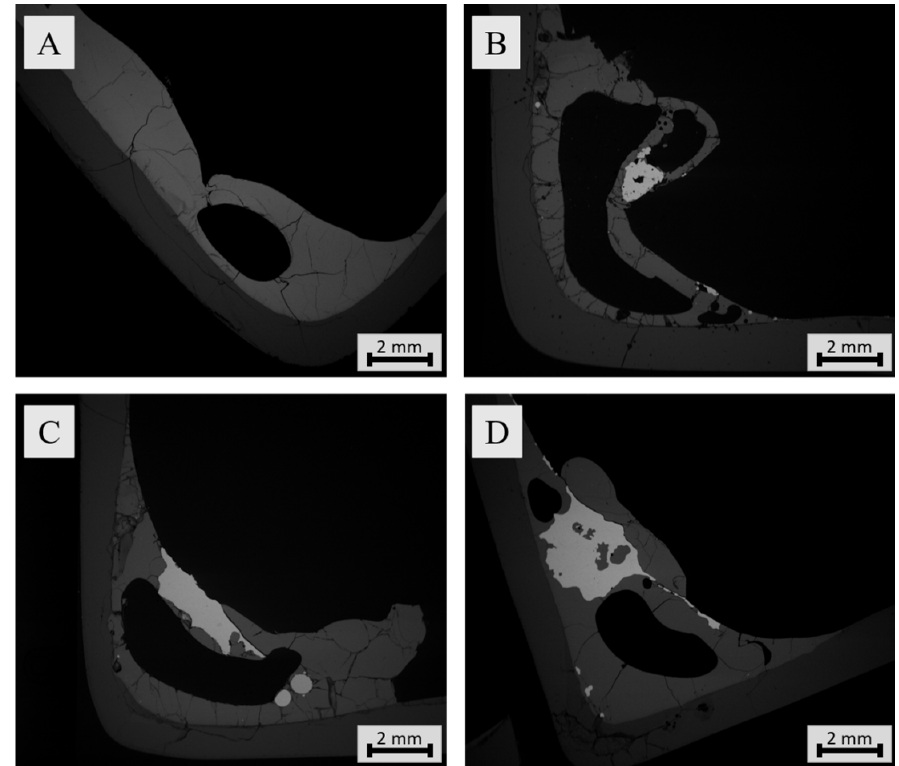
Figure 10. SEM-BSE micrographs of different samples: ( A ) molten slag without additions after 20 min contact time in argon atmosphere at 1400 °C, ( B – D ) samples with slag-battery slag mixtures after different contact time 5, 30 and 60 min, respectively, in argon atmosphere at 1350 °C. Metals 2020 , 10 , 680